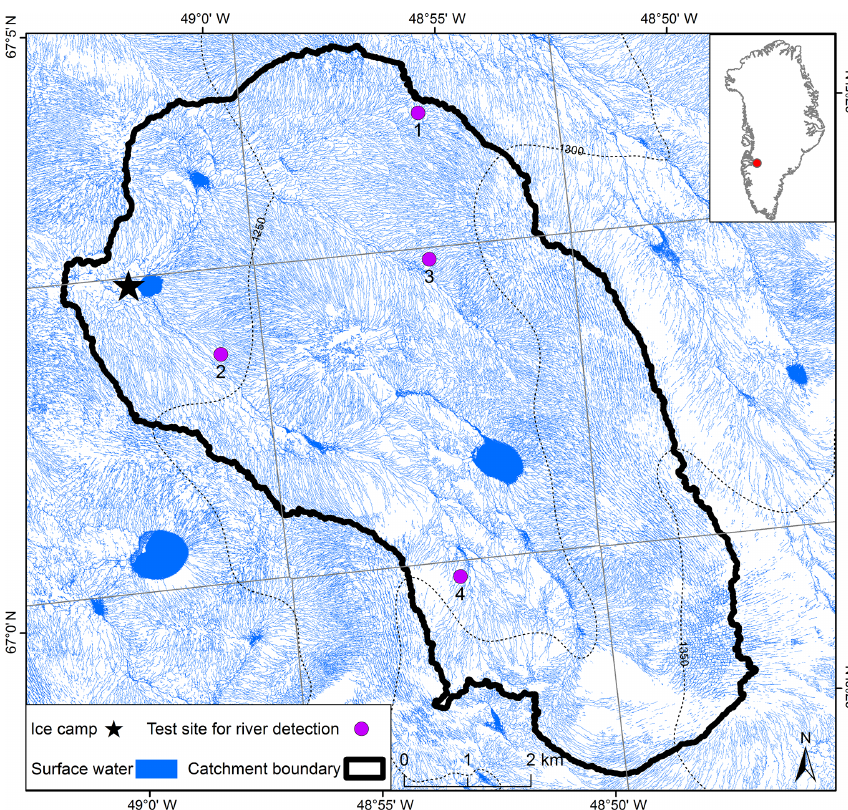
Figure 1. The Rio Behar catchment is a moderately sized internally drained catchment (IDC) on the southwest Greenland Ice Sheet. A highly developed supraglacial stream–river network was mapped from a high-resolution (0.5m) panchromatic WorldView-1 (WV1) image acquired on 18 July 2015. The catchment outlet moulin is under the black star and 5m MAR grid cells are shown in grey rectangles. A derivative 3m resolution DEM is used to delineate the topographic catchment boundary (black line). An in situ hourly hydrograph of supraglacial river discharge collected by Smith et al. (2017) (black star) was used to calibrate a Rio Behar catchment unit hydrograph (UH) for the rescaled width function (RWF) and surface routing and lake-filling (SRLF)